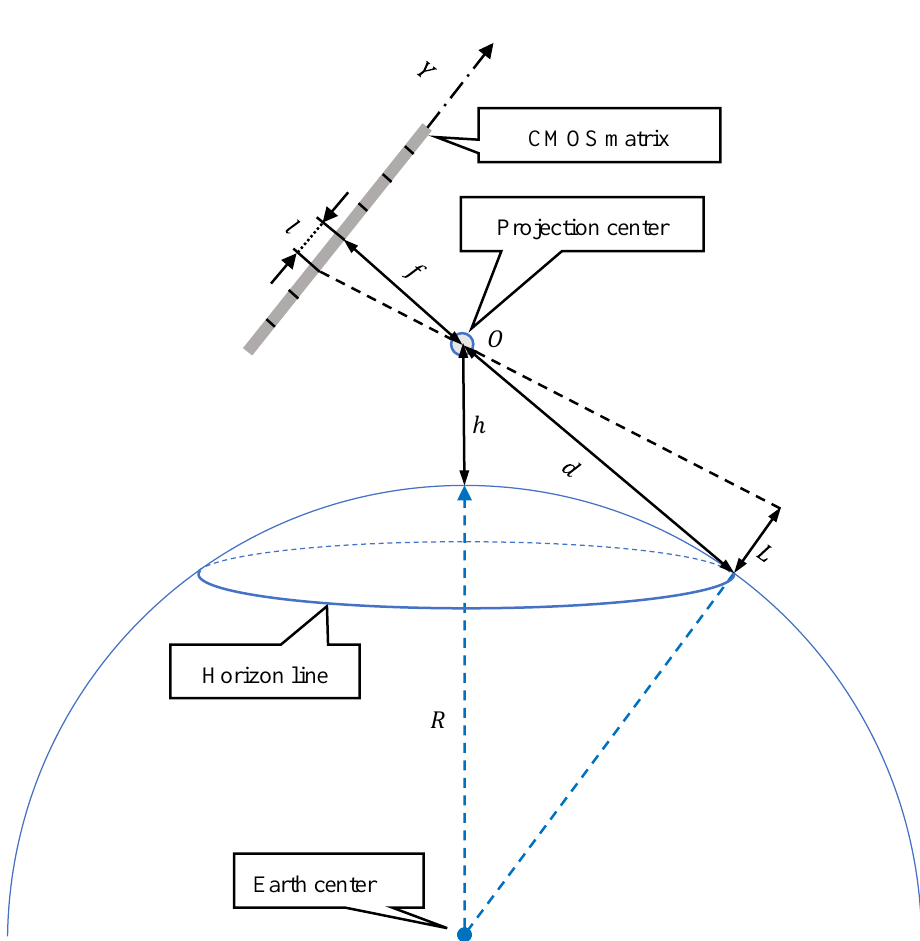
Figure 3. Graphic interpretation of the measurement resolution of a single-pixel representing the horizon line on the matrix.